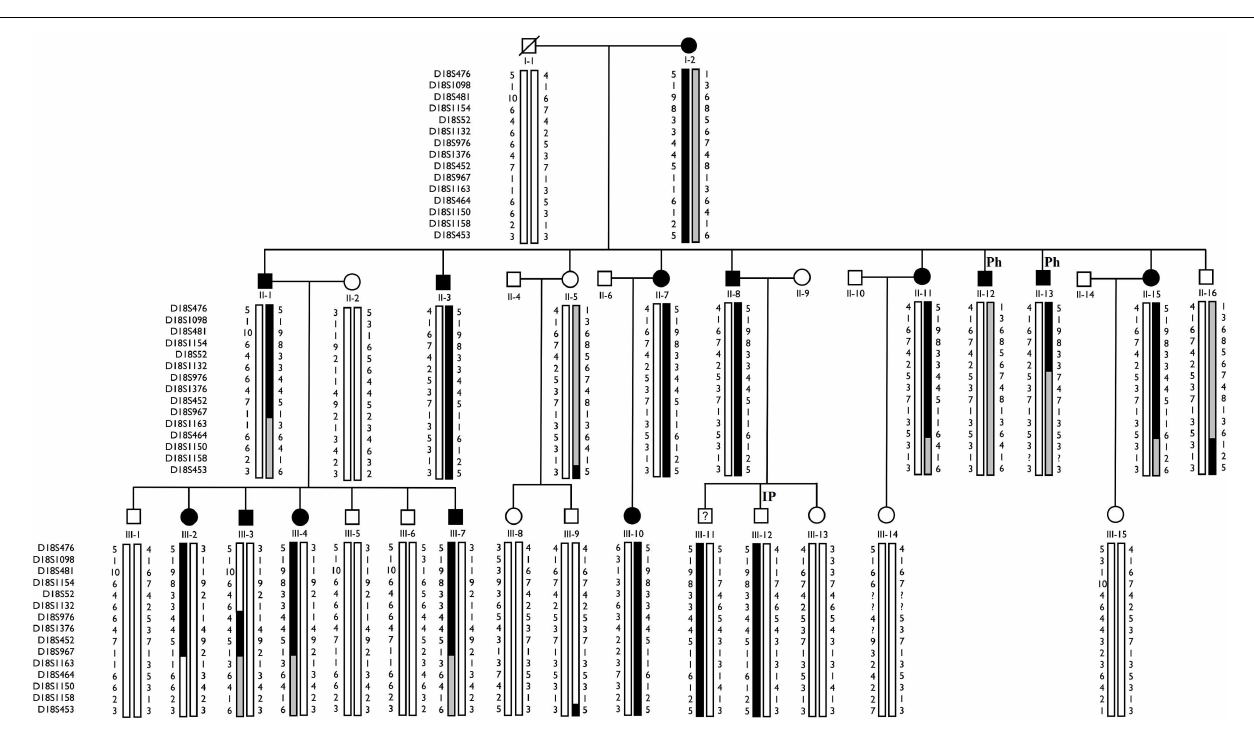
FIGURE 2 | Haplotype analysis of F-10 for 14 markers localized on chromosome 18p. The haplotype inherited by affected individuals is represented by blackened vertical bars. Family members who did